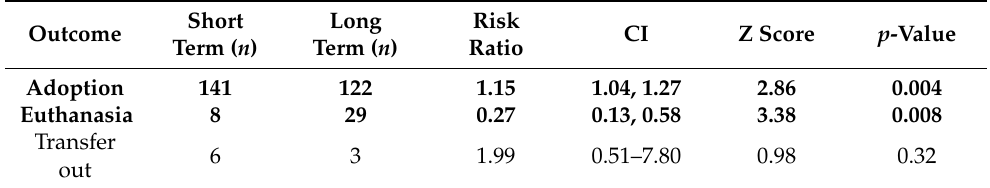
Table 2. Relative risk difference of common reasons for return in the short and long term. Bold indicates significant at the p < 0.05 level.